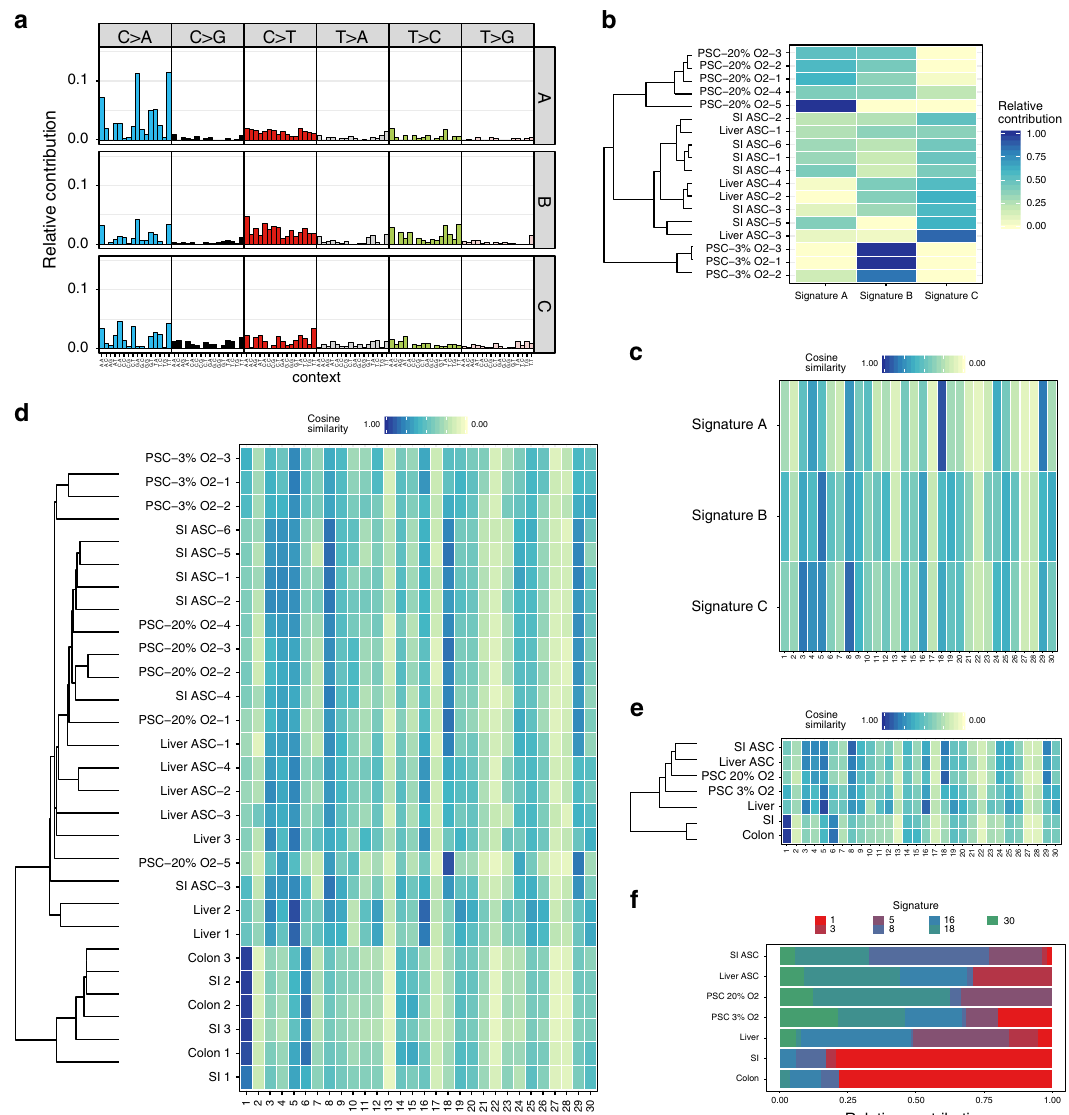
Fig. 3 Mutational signature analysis. a The 96-type mutational pro fi les of signatures A – C extracted by nonnegative matrix factorization from the mutational landscape of all in vitro samples. b Cosine similarity heatmap between the mutational pro fi les of the extracted signatures A – C and the samples. Unsupervised hierarchical clustering of the samples based on the relative contribution of the extracted signatures to the mutational pro fi le resulted in a clear segregation of the samples by cell type. c Cosine similarity heatmap between the mutational pro fi les of the extracted signatures A – C, and the COSMIC Signatures. e Cosine similarity heatmap between the COSMIC Signatures and the mutational pro fi les of the in vitro stem cell types and the previously described in vivo ASCs 24 . Liver = liver stem cells in vivo, SI = intestinal stem cells in vivo, colon = colon stem cells in vivo. Unsupervised hierarchical clustering of the samples was performed based on the cosine of the mutational pro fi le to the COSMIC Signatures. d Cosine similarity heatmap between COSMIC Signatures and the mutational pro fi les of all in vitro stem cell subclones and the previously described in vivo ASCs 24 . Liver = liver stem cells in vivo, SI = intestinal stem cells in vivo, colon = colon stem cells in vivo. Unsupervised hierarchical clustering of the samples was performed based on the cosine of the mutational pro fi le to the COSMIC Signatures. f Relative contribution of the COSMIC Signatures to the different stem cell